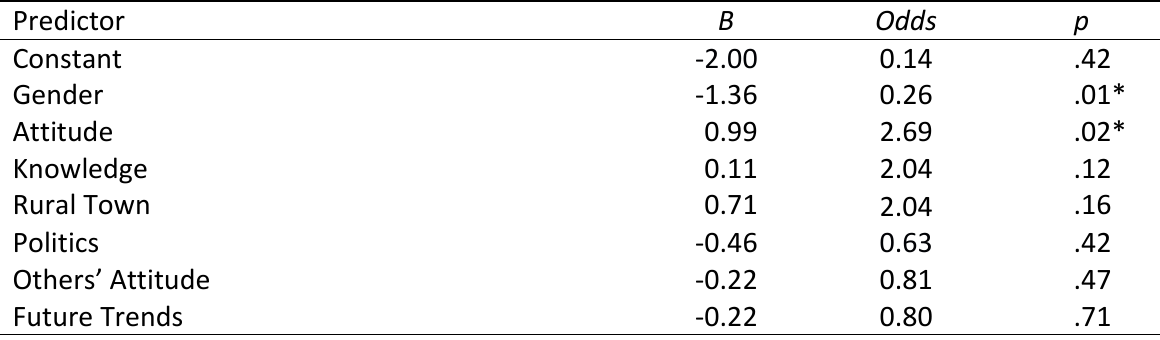
Likelihood of Purchasing Industrial Hemp